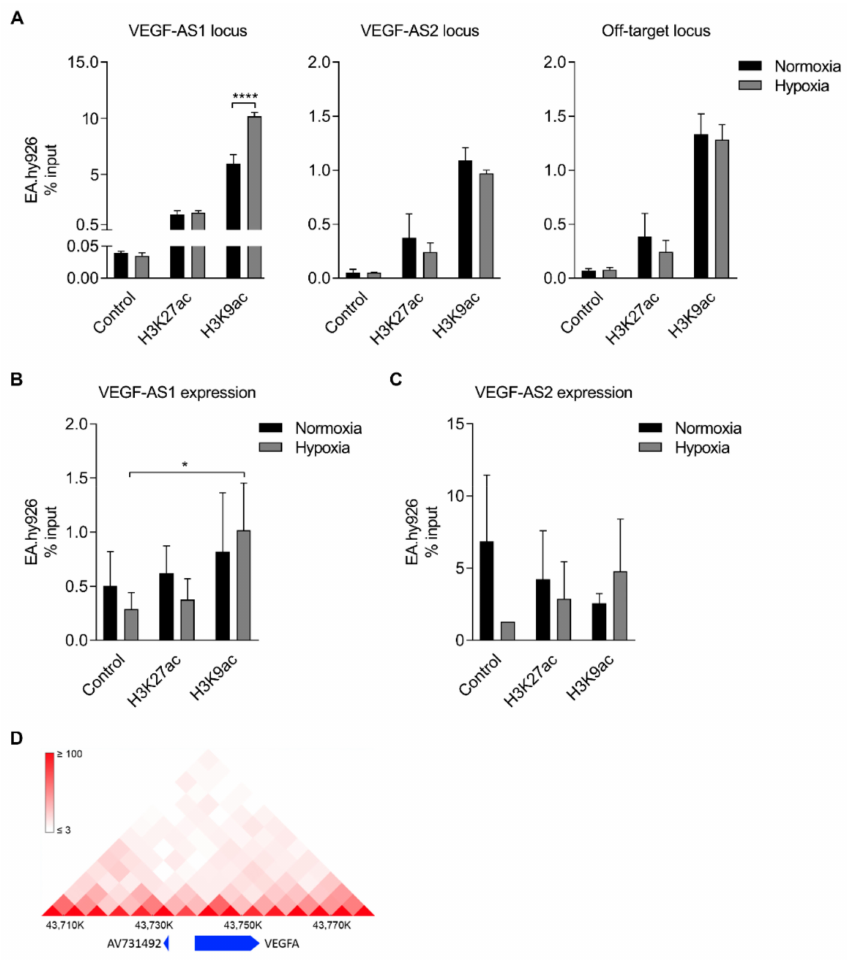
Figure 4. Strong enhancer marks are associated with VEGF-AS1 and VEGF-AS2 ; ( A ) A qPCR analysis of H3K27ac and H3K9ac enrichment at the VEGF-AS1 , VEGF-AS2 and off-target loci in normoxic and hypoxic EA.hy926 cells. IgG is used as a control. The data are presented as mean ± SD and standardized to inputs ( n = 3 independent experiments). Significance was measured by two-way ANOVA. **** p < 0.0001; ( B ) A qRT-PCR analysis of H3K27ac and H3K9ac association with VEGF-AS1 in normoxic and hypoxic EA.hy926 cells. IgG is used as a control. The data are presented as